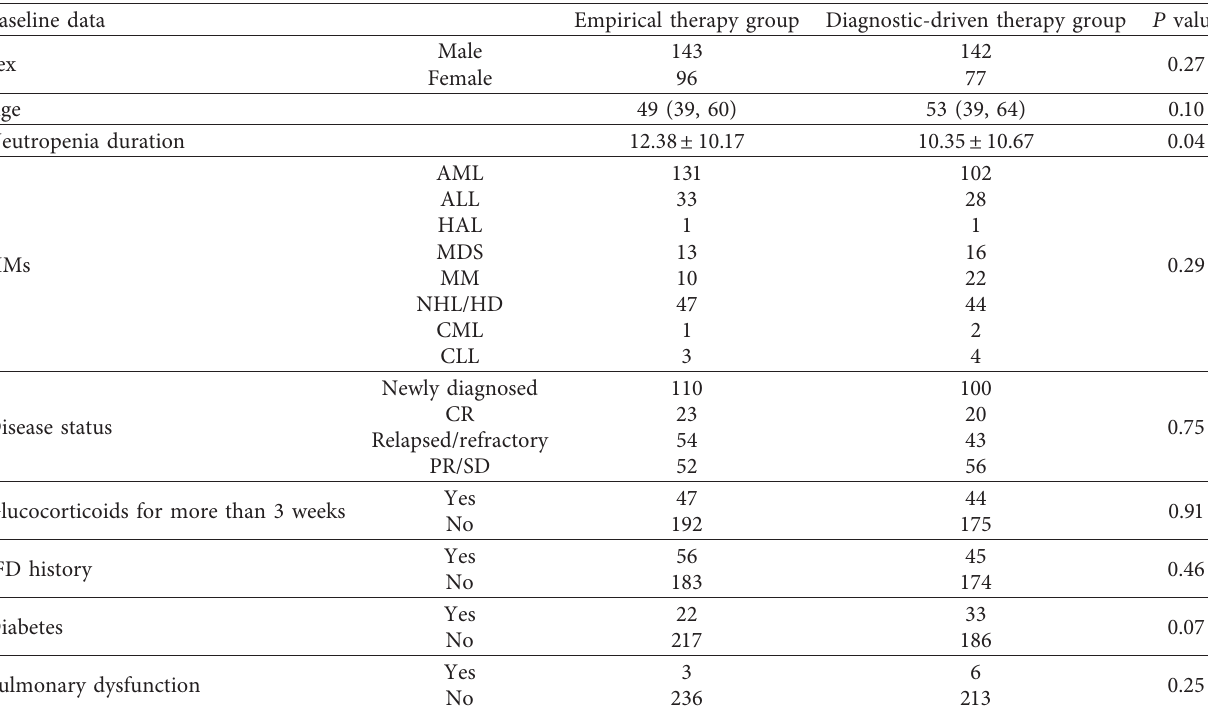
Figure 1: Flowchart illustrating the population and design of this study. Table 2: Patients’